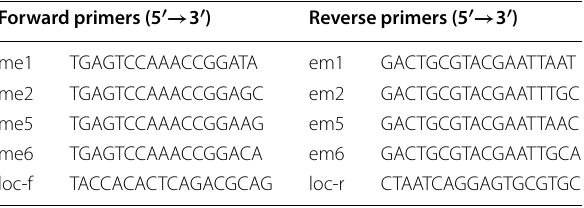
Table 1 List of primers for SRAP marker